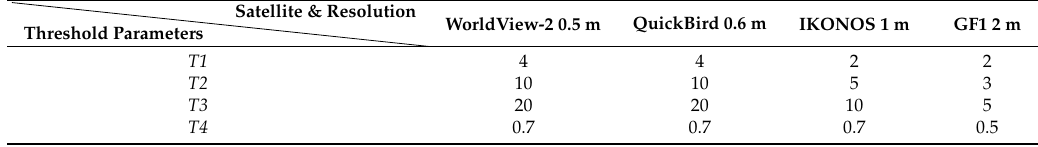
Table 1. Comparison of the threshold parameters in different satellite resolution